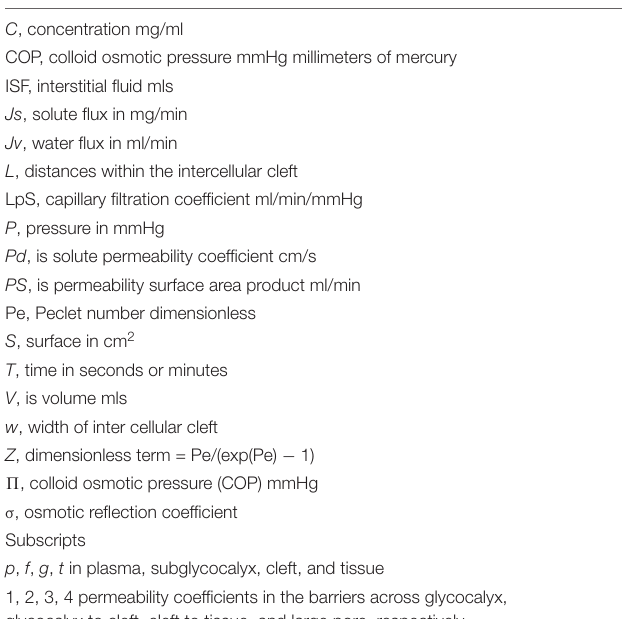
TABLE 1 | Symbols, abbreviations, and subscripts.